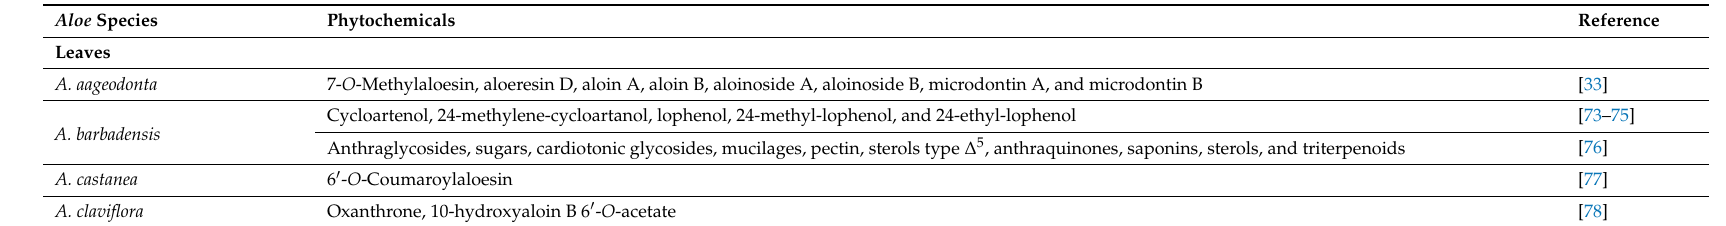
Table 5. Phytoconstituents of Aloe species extracted with non-specified